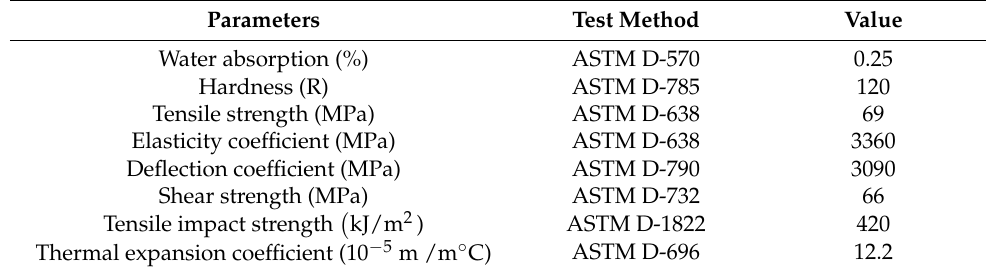
Table 1. Properties of DuPont POM-100 P.